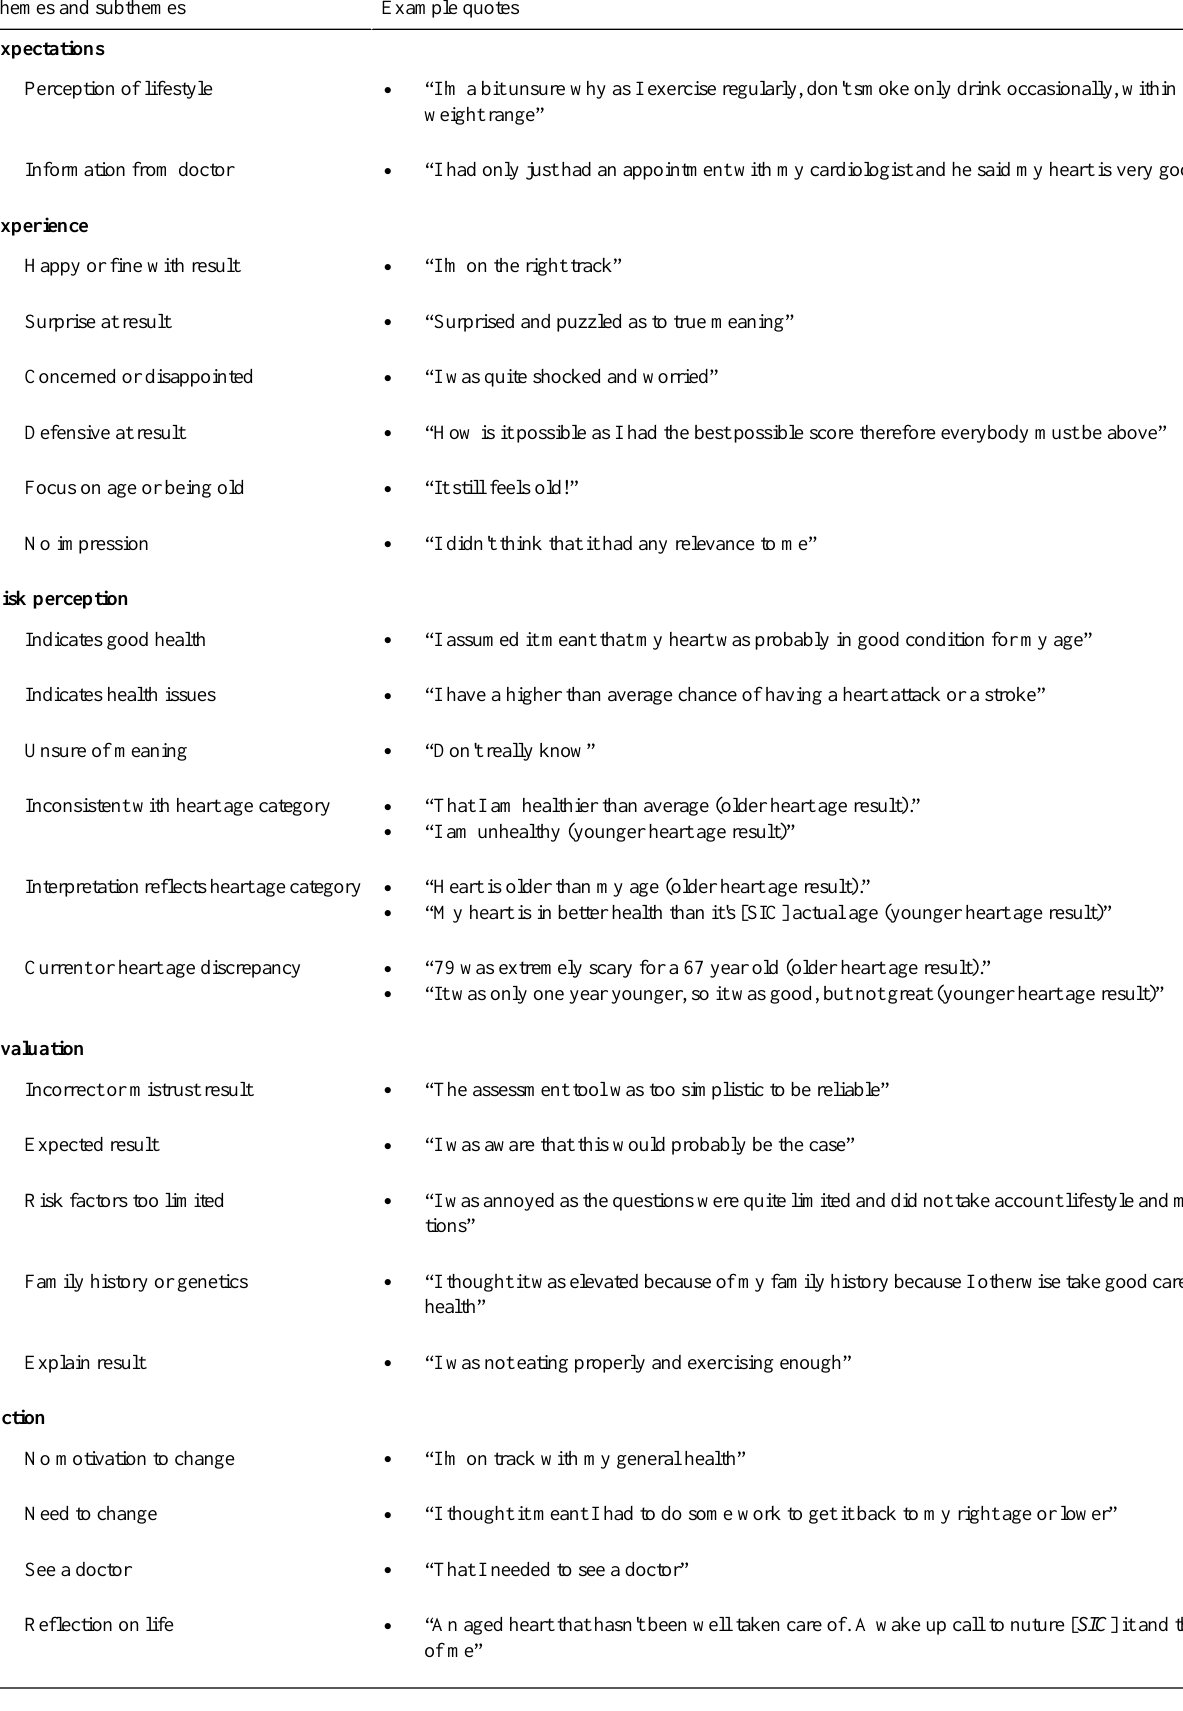
Example quotesThemes and